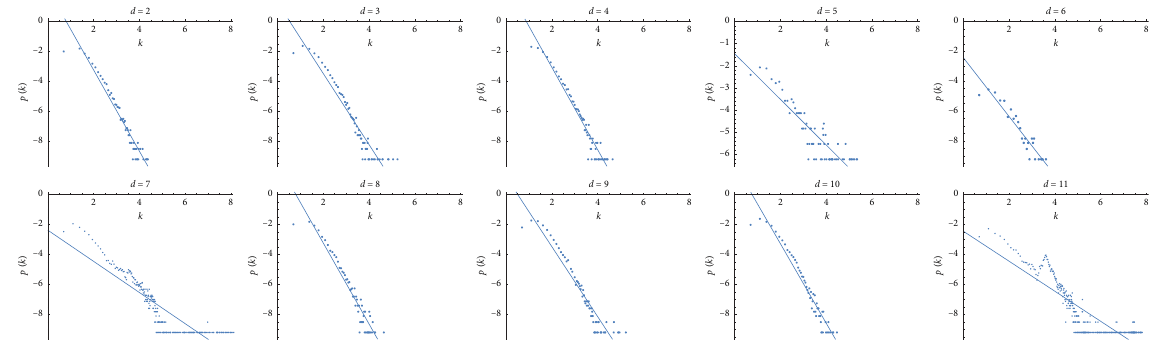
Figure 1: The degree distribution found in the NV graphs (dots) and the corresponding fitted function Ak − c (solid line) for d ∈ 2 , 3 , ... , 11 { } .